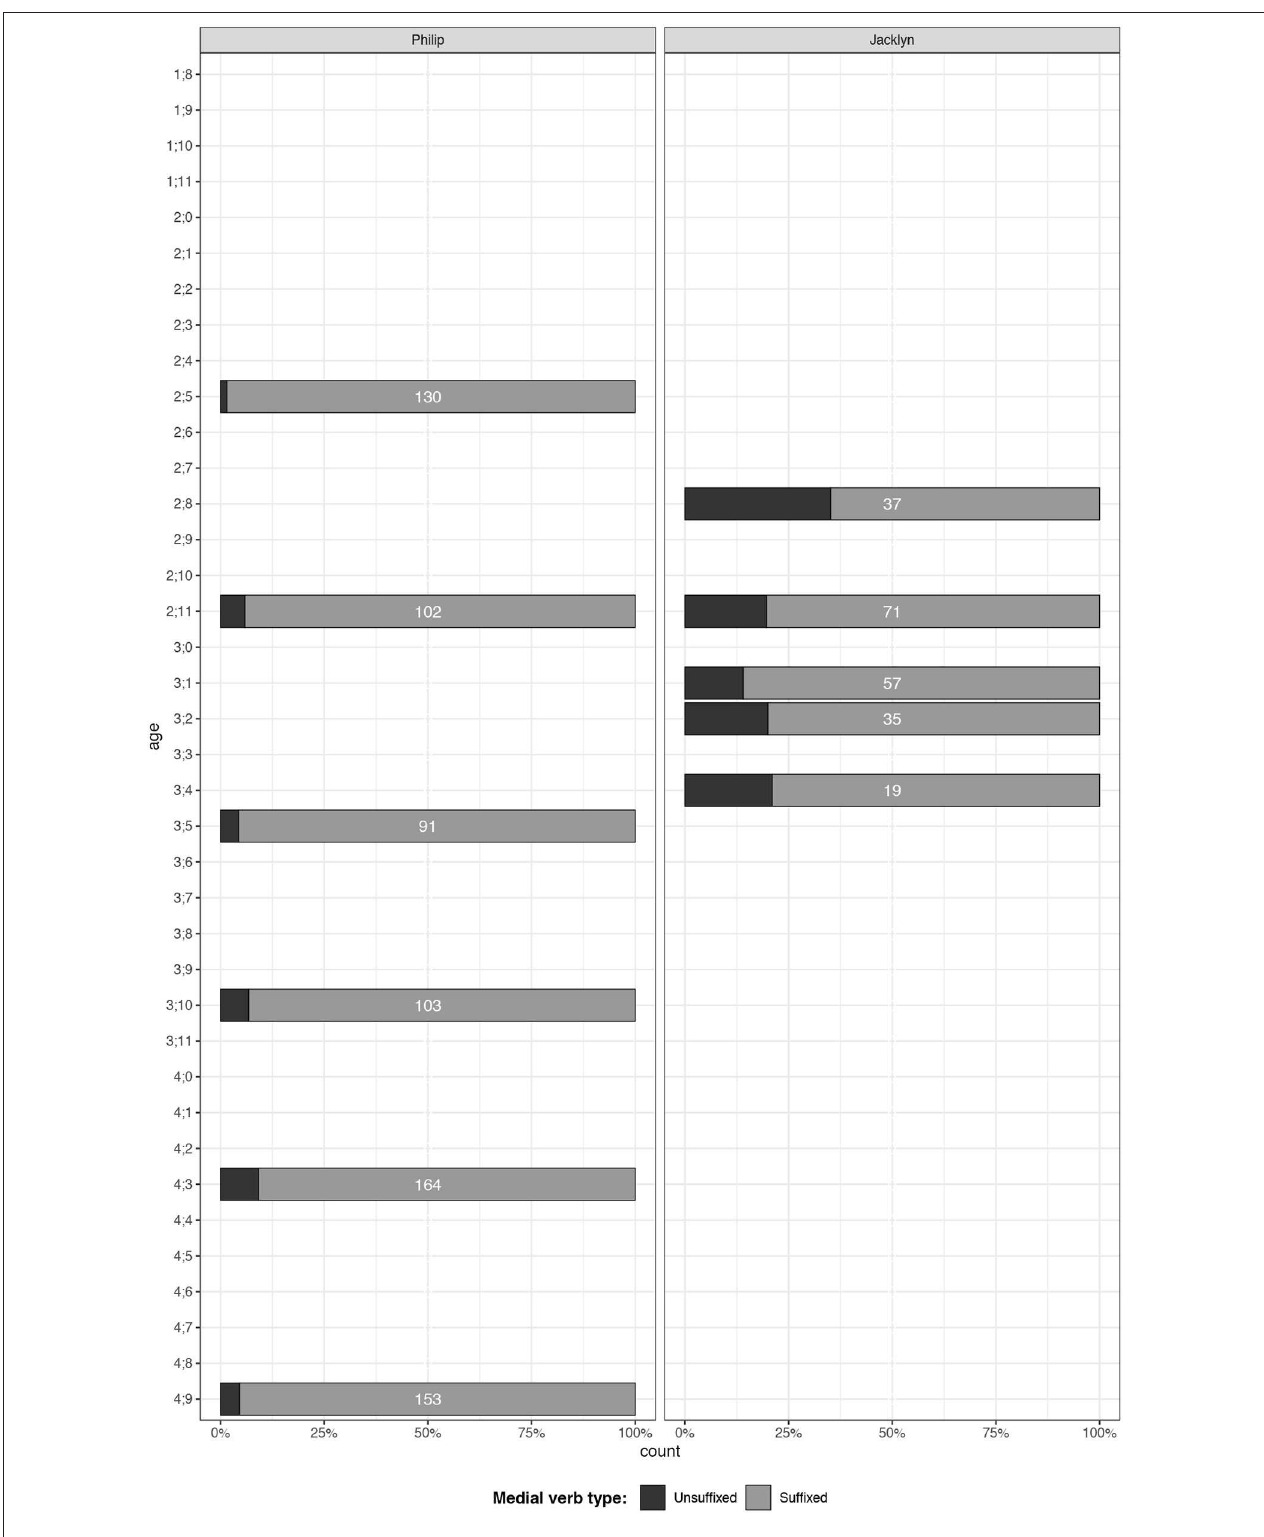
FIGURE 14 | Presence vs. absence of suffixes on Medial verbs in speech of adults to Philip and Jacklyn.